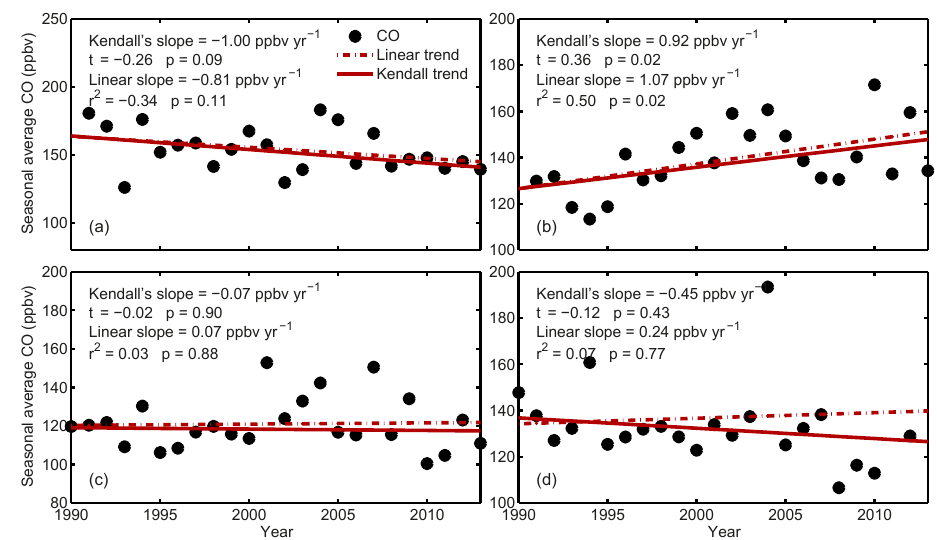
Figure 10. Mann–Kendall and linear trends of seasonal average CO observed during (a) spring, (b) summer, (d) autumn, and (d) winter from 1990 to 2013 at